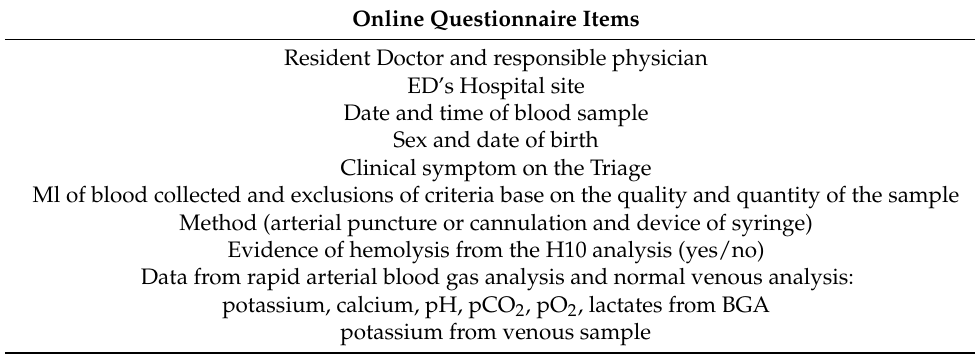
Table 1. Online questionnaire items to collect data. ED, Emergency Department; pCO 2 , partial pressure of carbon dioxide; pO 2 , oxygen partial pressure; BGA, blood gas analisis.